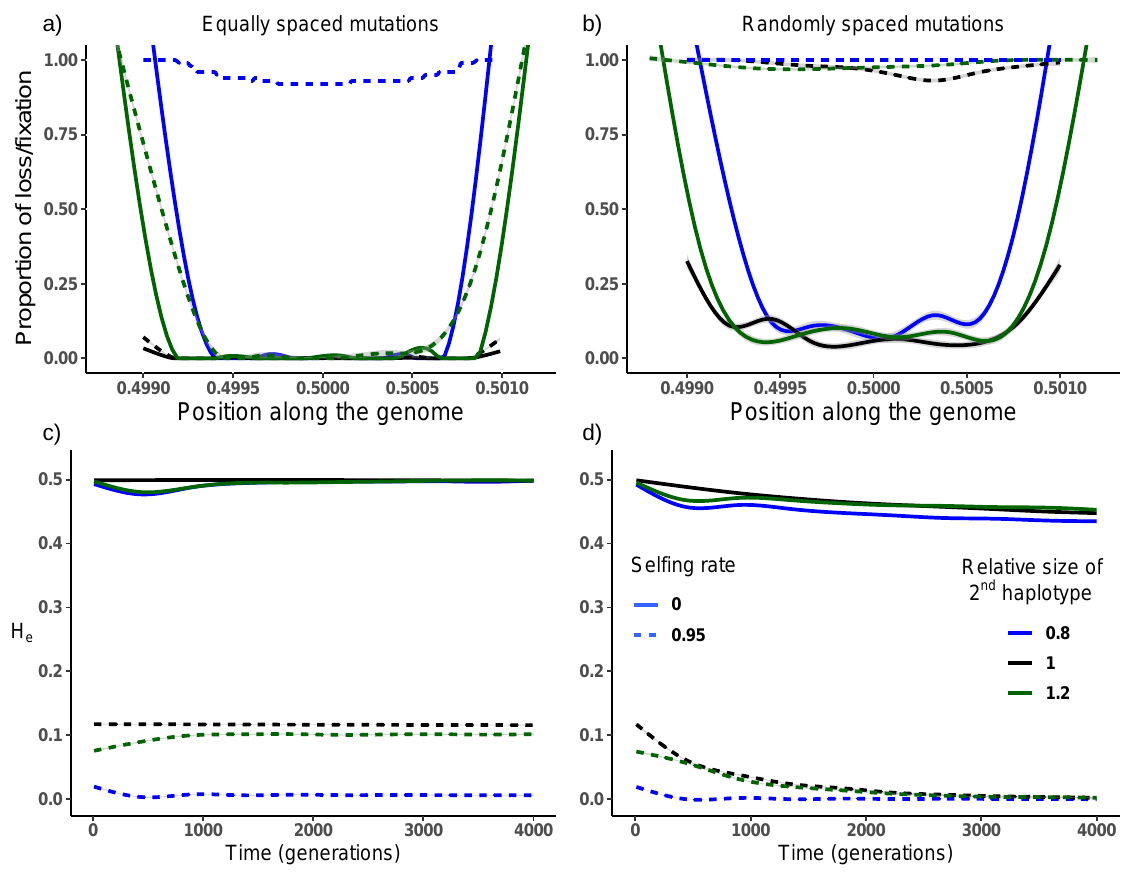
Figure S5 – Effects of relaxing the assumptions of symmetric overdominance and evenly spaced mutations. Upper panels show locations within the POD zone where load muta- tions are most likely to be lost after 4000 generations (a, b) and how this depends on whether mutations are evenly spaced (a) or randomly distributed (b). Results are shown for both symmetric (black) and asymmetric (green and blue) loads. Outcomes under both outcrossing and high selfing (solid vs. dotted lines) are shown. Note erosion of mutations via recombination and selection at both ends of the POD zone. Lower panels show over- all stability of the POD zone (shown as heterozygosity, He ) over time. As in the upper panels, graphs show results for both symmetric (black) and asymmetric (green and blue) loads and for evenly (panel c) and randomly (panel d) placed mutations. The coefficients of selection and dominance are s = 0.01 and h = 0.2 respectively, linkage within the 5 POD zone is ℓ = 10 − and population size N = 1000